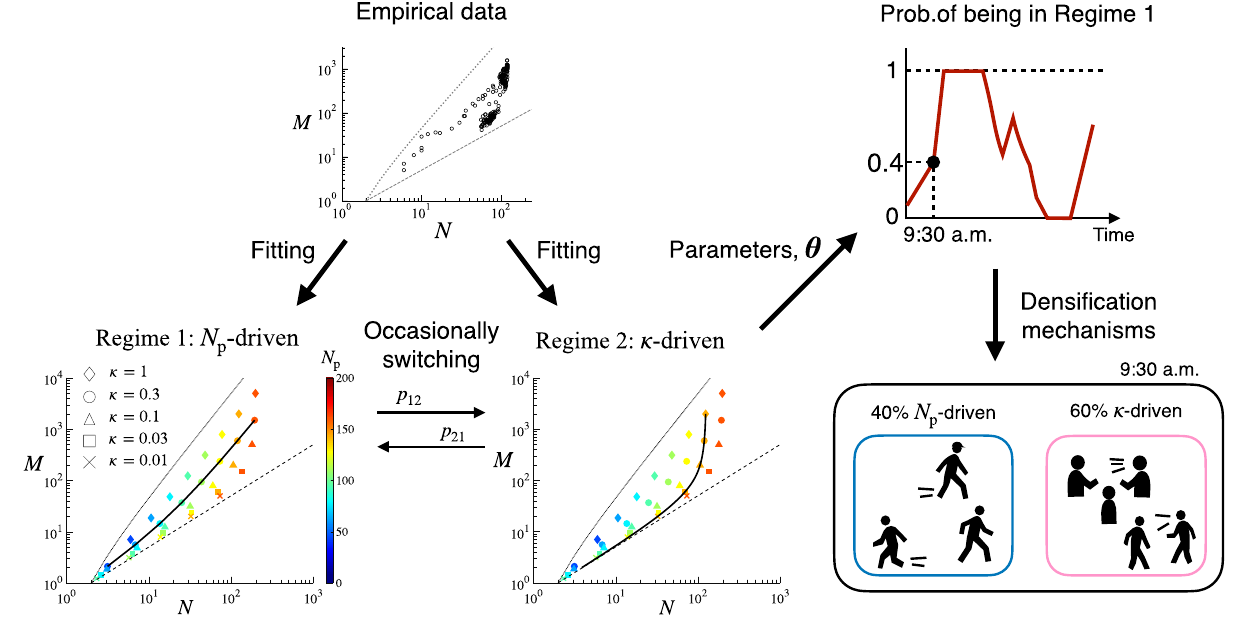
Figure 2. Schematic of the identification method. Empirical densification is fitted to the regime switching model in which the model switches from Regime 1 to Regime 2 (resp. from Regime 2 to Regime 1) with probability p 12 (resp. p 21 ). Then, the estimated parameters are used to infer the probability of the system being in Regime 1 at a given time t . For panels at lower left and lower middle, different colours denote different N p , and different symbols denote different κ (see Eqs. 2 and 3). Solid line in the bottom left (resp. bottom middle) 126 ). If the scaling is N p -driven (resp. κ 0.3 (resp. N p denotes the N p -driven (resp. κ -driven) scaling with κ = = -driven), the time variation of N and M is fully caused by shifts in N p (resp. κ